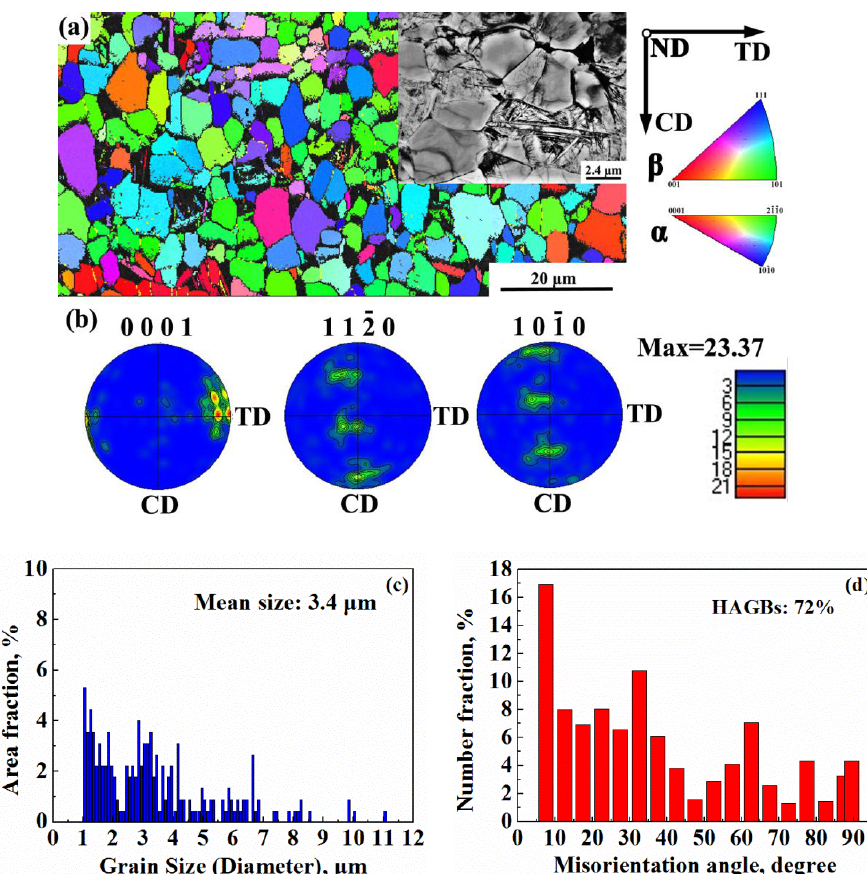
Figure 8. Microstructure and microtexture of Ti-6Al-4V specimens deformed at 900 °C/10 −3 s −1 : ( a ) the orientation map, ( b ) pole figure, ( c ) distribution of grain size of α phase, and ( d ) grain boundary misorientation of α phase.